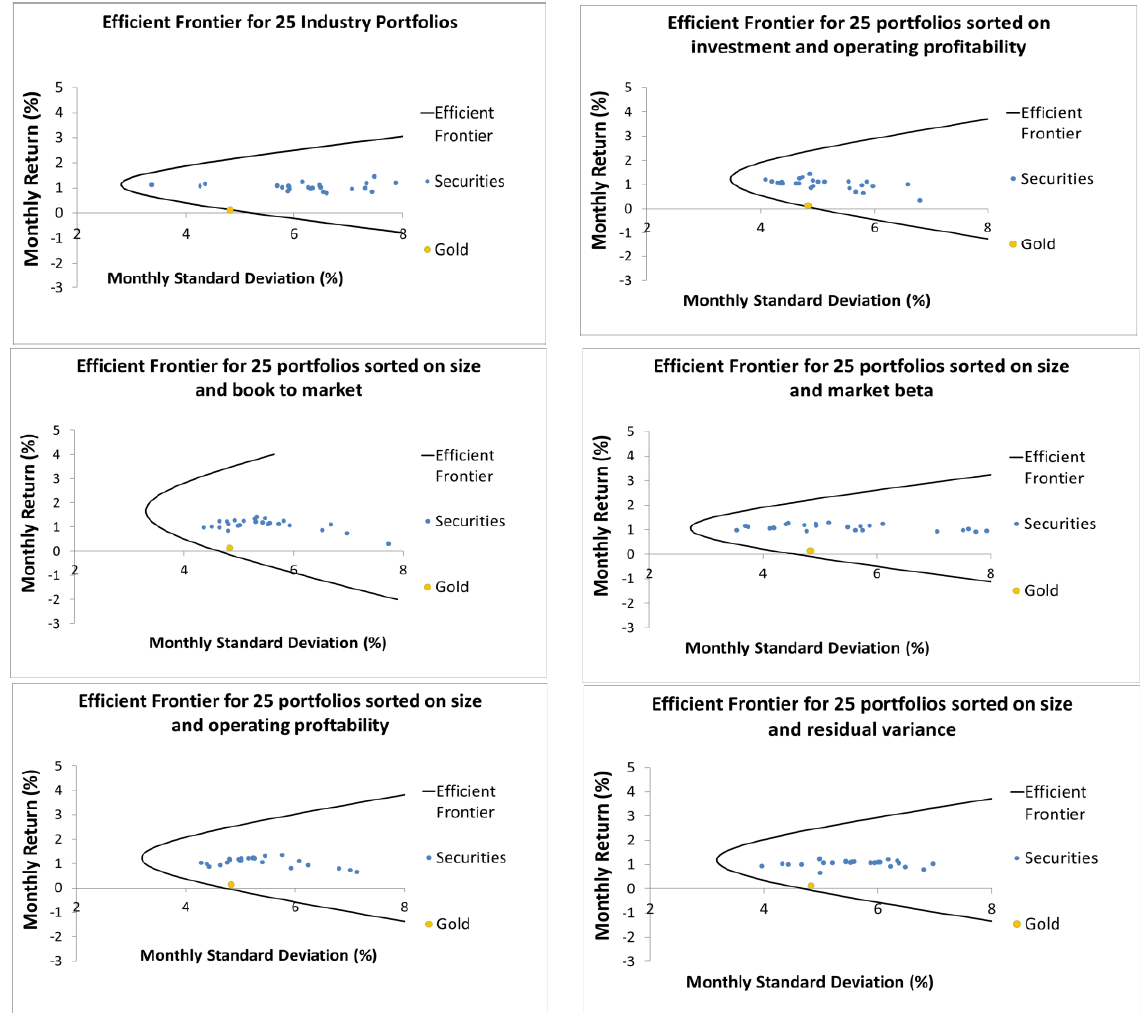
Figure 2. Position of gold on the minimum variance Frontier in the US equity market when it is plotted against the 25 US industries.